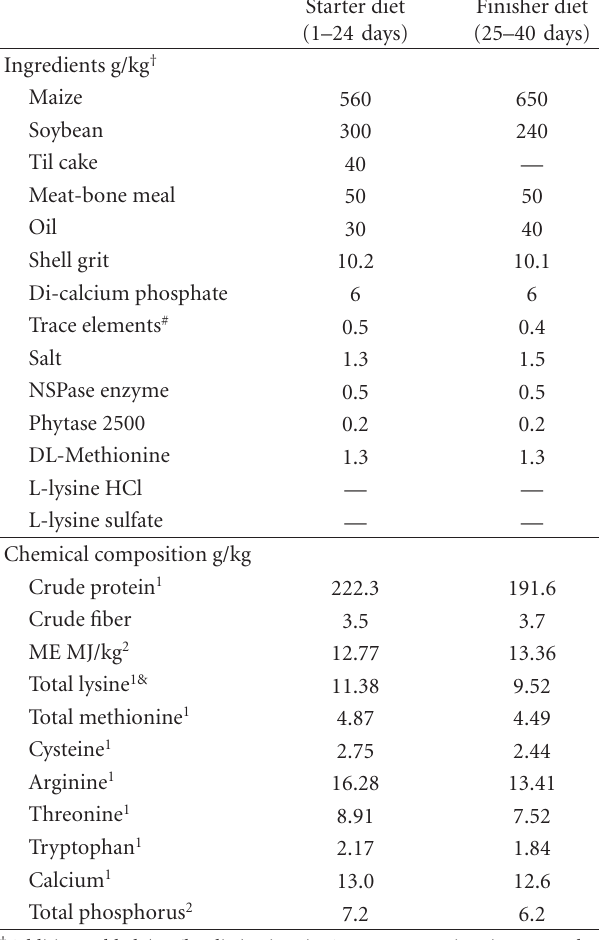
Table 1: Ingredients and chemical composition (dry matter basis) of the basal